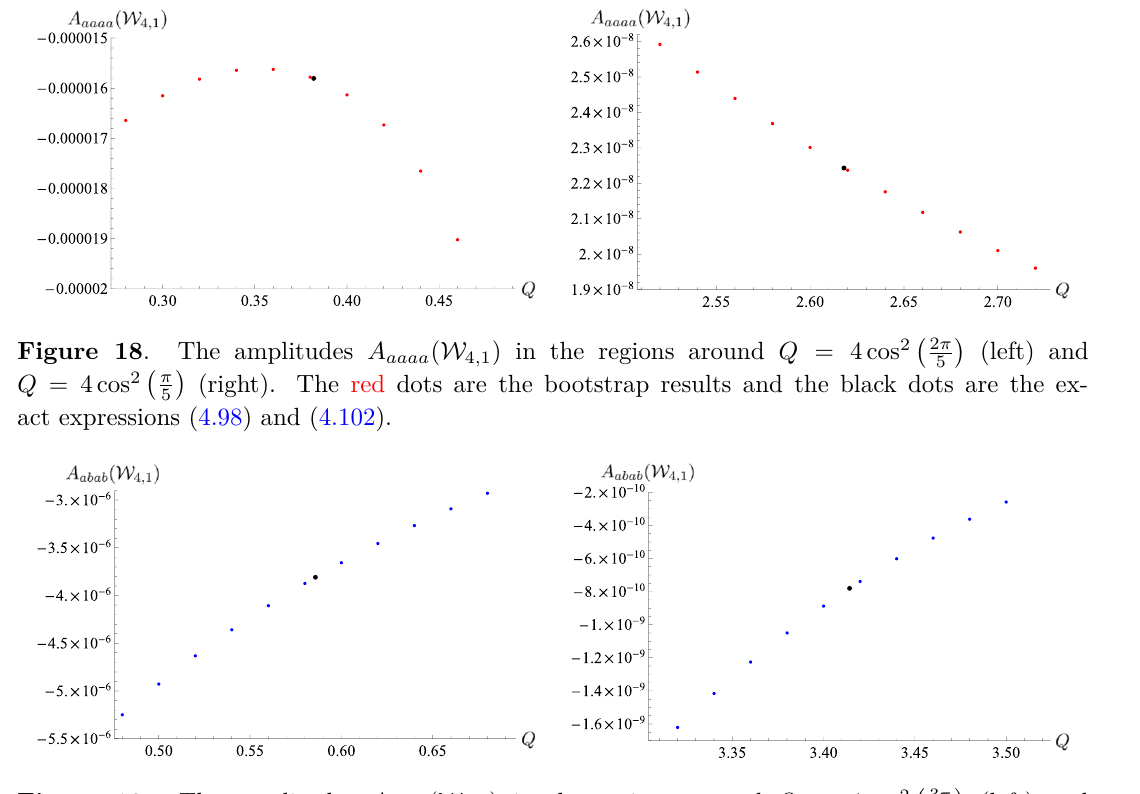
Figure 19 . The amplitudes A abab ( W 4 , 1 ) in the regions around Q = 4 cos 2 (cid:0) π (cid:1) Q = 4 cos 2 (right). The blue dots are the bootstrap results and the black dots are the ex- 8 act expressions (4.103a) and